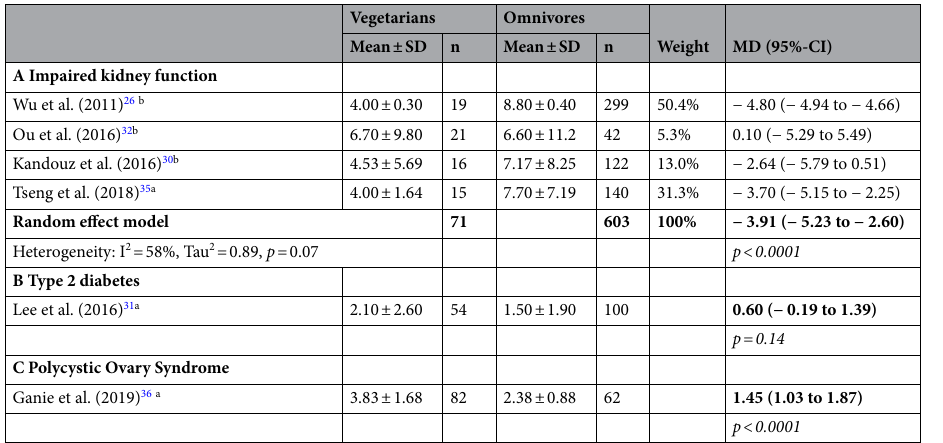
Table 3. Summarized mean differences showing the overall effect of vegetarian diet on CRP concentrations compared to omnivorous diet in patients with impaired kidney function (A), type 2 diabetes (B) and PCOS (C). a measured hs-CRP [mg/l] ; b measured CRP [mg/l]; Results are presented as mean difference (MD) (95%-